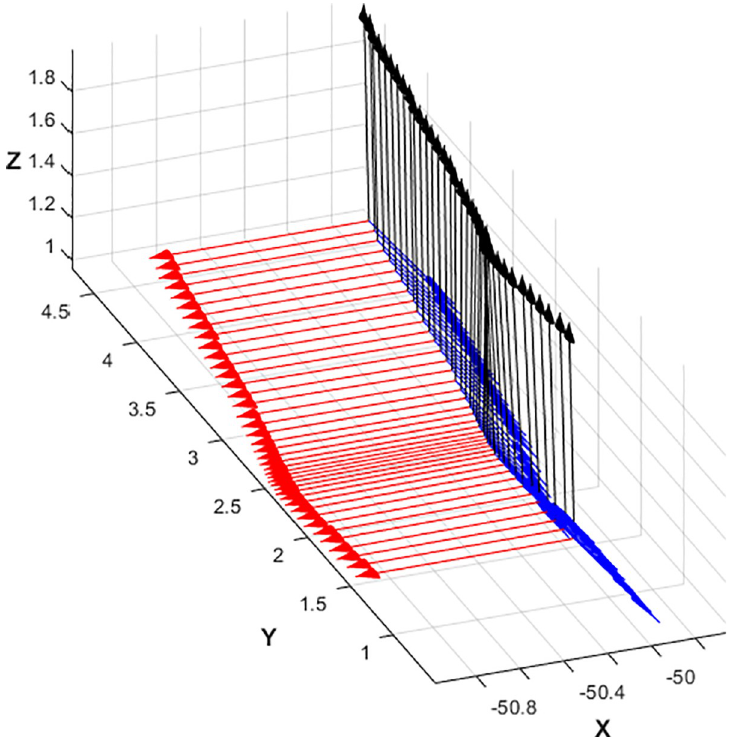
Fig 14. Polarization vector evolution at receiving antenna in a real flight.